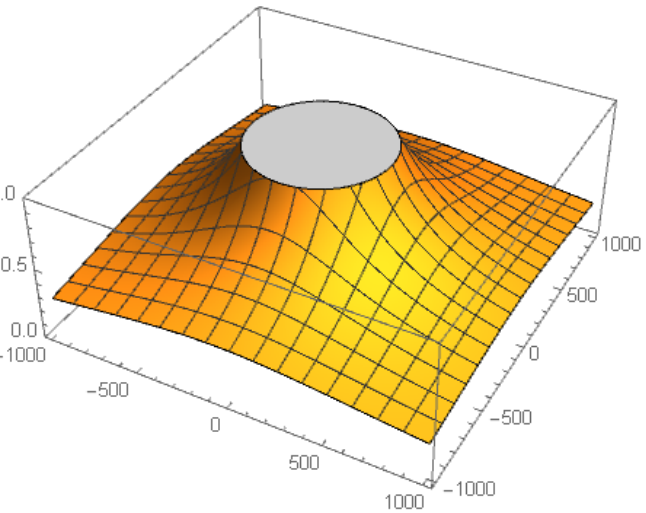
Figure 1. Stability surface of ex 1 = 1 (in gray color, the complex area where the fixed point is repulsive, being attracting in the